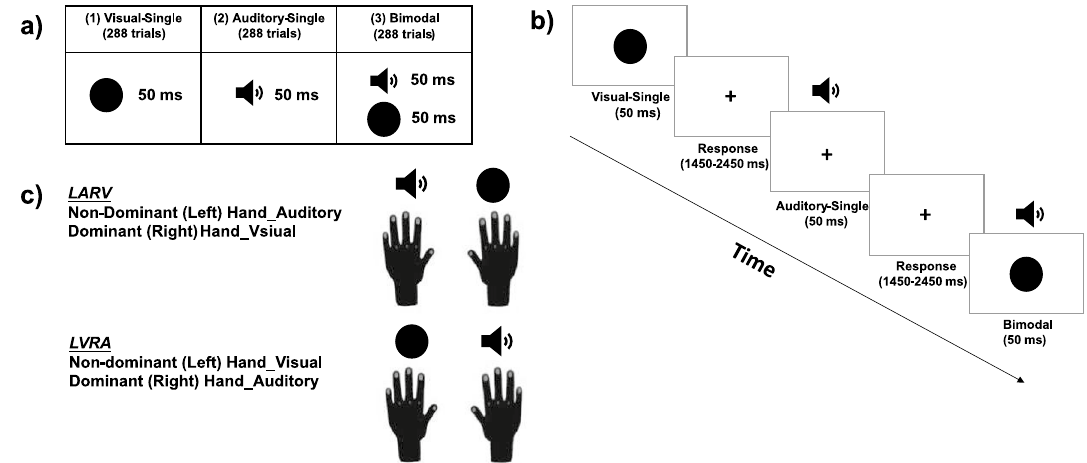
Figure 1. Experimental design ( a ) stimuli in the adapted Colavita paradigm adopted in the current study. Three types of stimuli were used: the unimodal visual target, the unimodal auditory target, and the